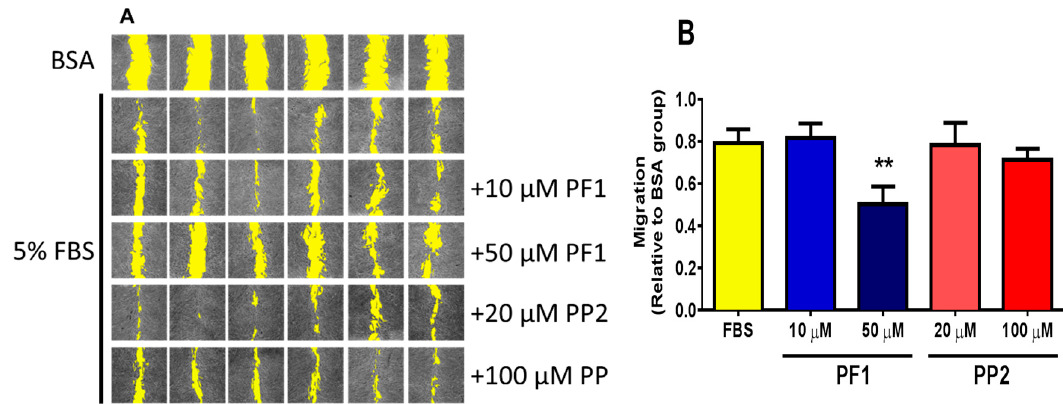
Figure 6. PF1 inhibits FBS-stimulated wound healing of MDA-MB-231 cells. MDA-MB-231 cells (12.5 × 10 3 cells/well) were seeded in 96-well plates in complete media. Once they reached 100% confluence, complete media was replaced with media containing 0.1% faf-BSA for 24 h. A wound was then applied, and media was replaced with media containing or not PF1 or PP2 30 min before adding FBS to a final concentration of 5% ( v/v ). Panel ( A) shows representative images of wound-healing assays after 24 h. Cell-free areas are highlighted in yellow. Panel ( B) shows a comparison of cellular migration. The following symbol denotes a statistical significance when compared to the control group: *, p < 0.01.